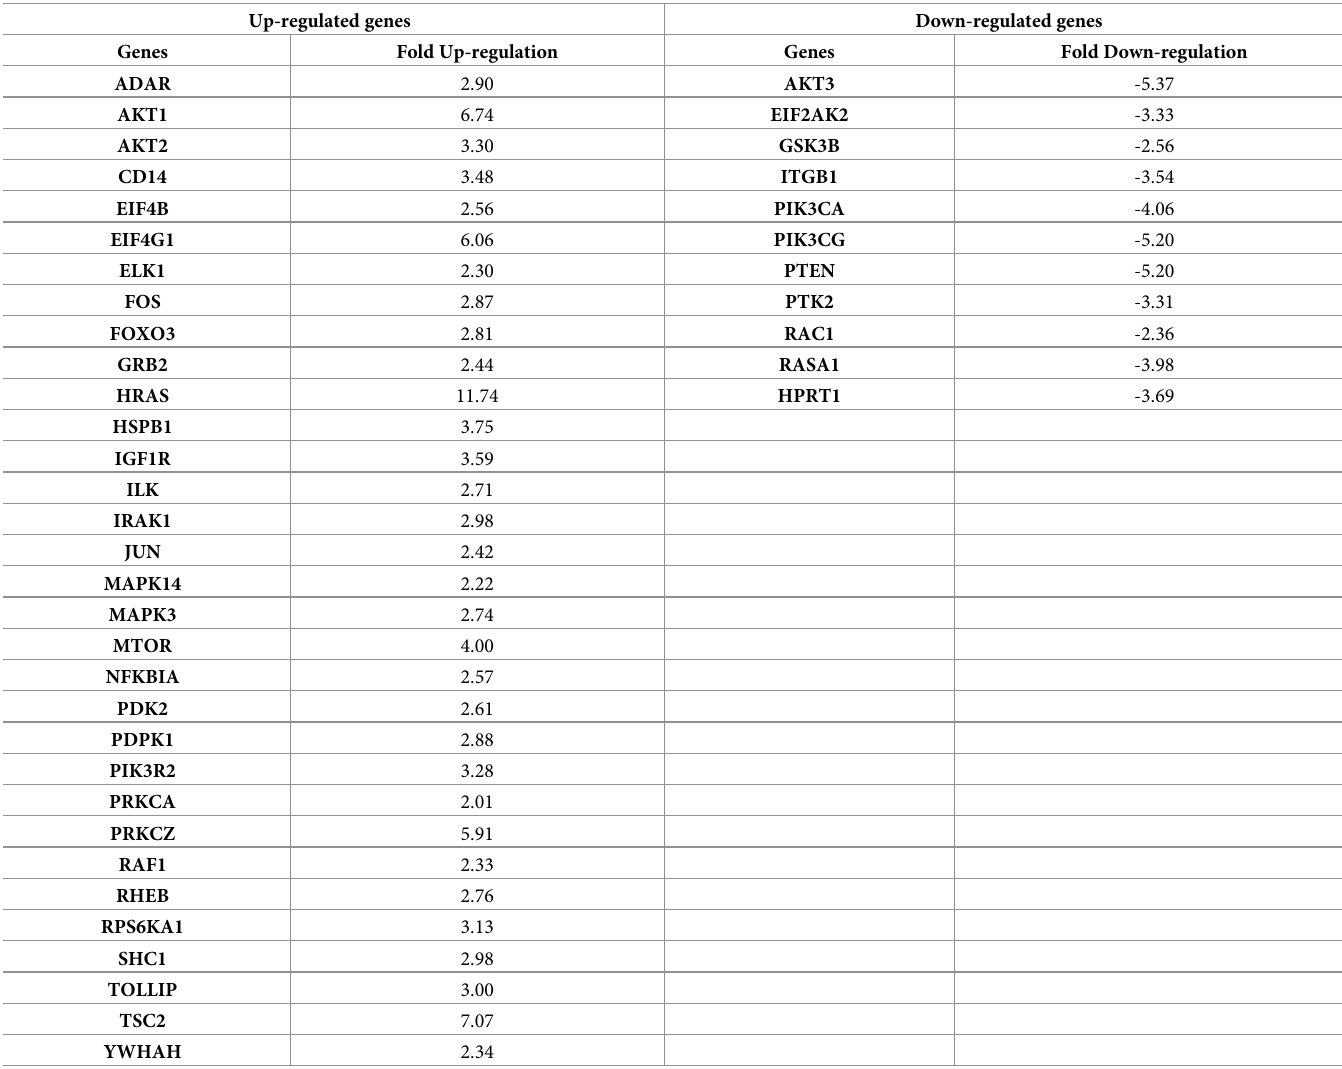
Table 4. Genes in PIK3/AKT pathway which are upregulated and down-regulated in the disease group as compared to the control group. Up-regulated genes